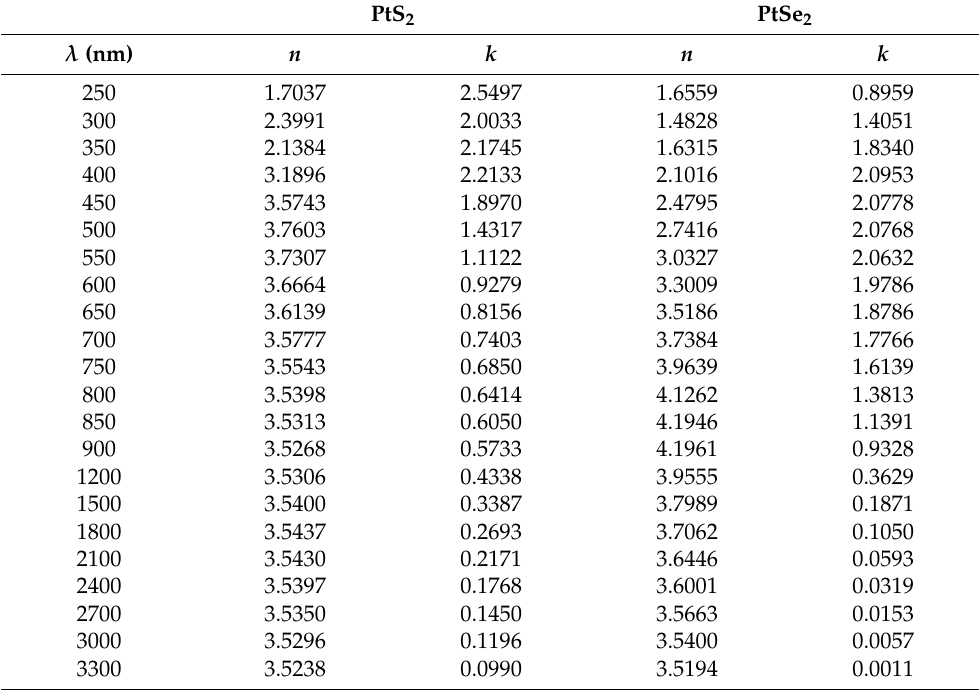
Table A1. Tabulated optical constants for PtS 2 and PtSe 2 films from Figure